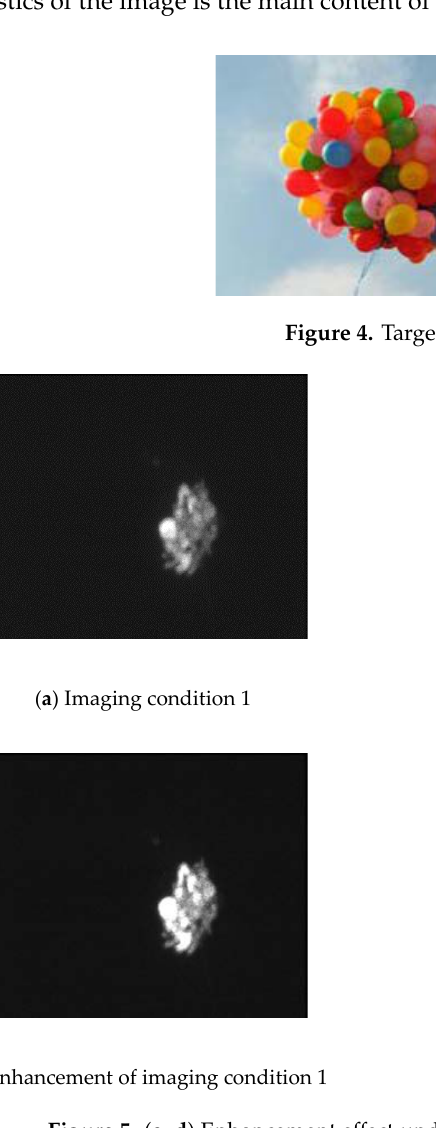
Figure 5. ( a – d ) Enhancement effect under different imaging conditions.